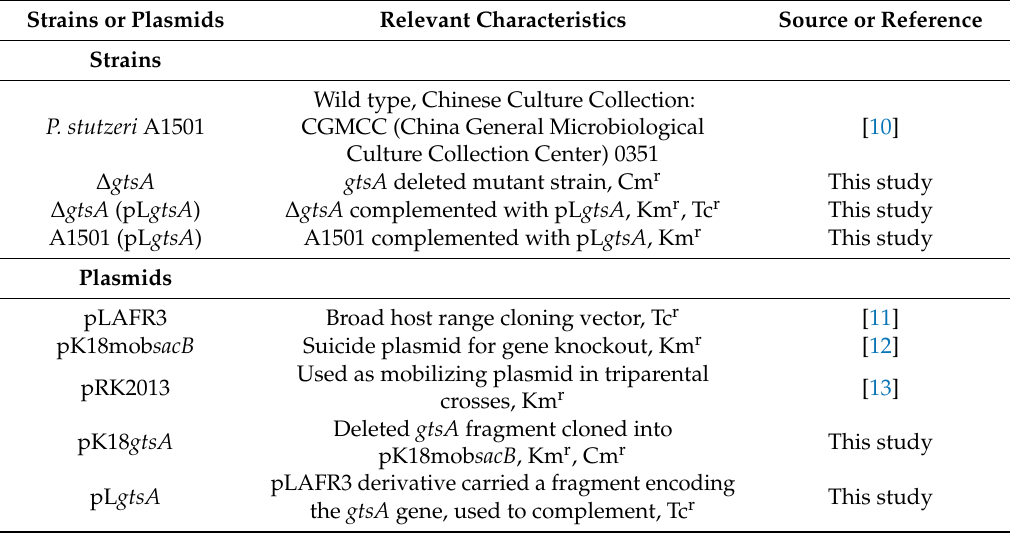
Table 1. Strains and plasmids used in this